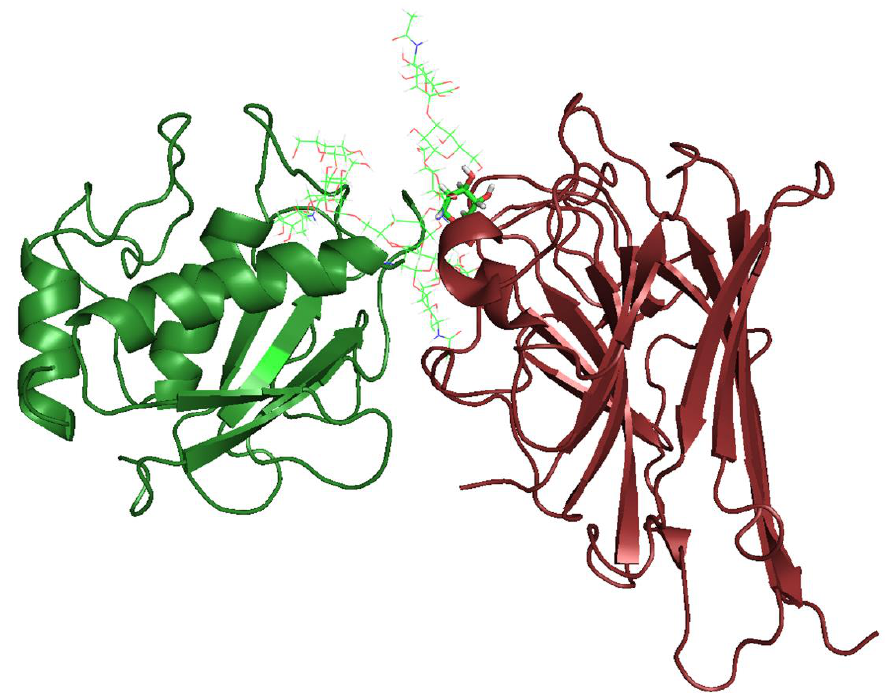
Figure 6. Interaction between ConGF (in red) and MMP1 catalytic domain (in green). Proteins are represented in cartoon and glycan N009 in green lines. The mannose residue interacting with ConGF CRD is highlighted in stick representation.